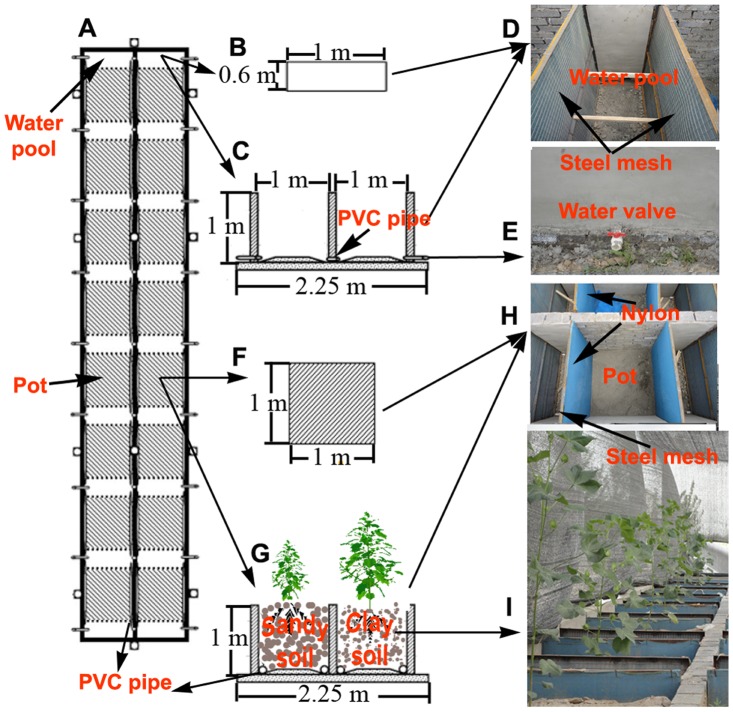
Schematic diagram of the experiment.(A) Plan form of experimental device; (B) plan form of water pool; (C) cross section of water pool; (D) photograph of water pool; (E) water valve; (F) plan form of pot; (G) cross section of pot; (H) photograph of pot; and (I) photograph of experimental plants. The experimental devices (A) were constructed by cement. Each device was divided into 2×8 cells. Each cell contained a pot and a water pool. Each pot (1 m ×1 m ×1 m) was located between two water pools (0.6 m ×1 m ×1 m). The steel mesh (covered with nylon) was used to separate the pot from the water pools, and all water pools in the device were connected by PVC pipes (the length of PVC was 1.2 m; A, G). The left pools were also connected with right pools by PVC pipes (C). Thus the water could run-through the whole device. The left pots were filled with sandy soils, and the right pots with clay soils (G, I).